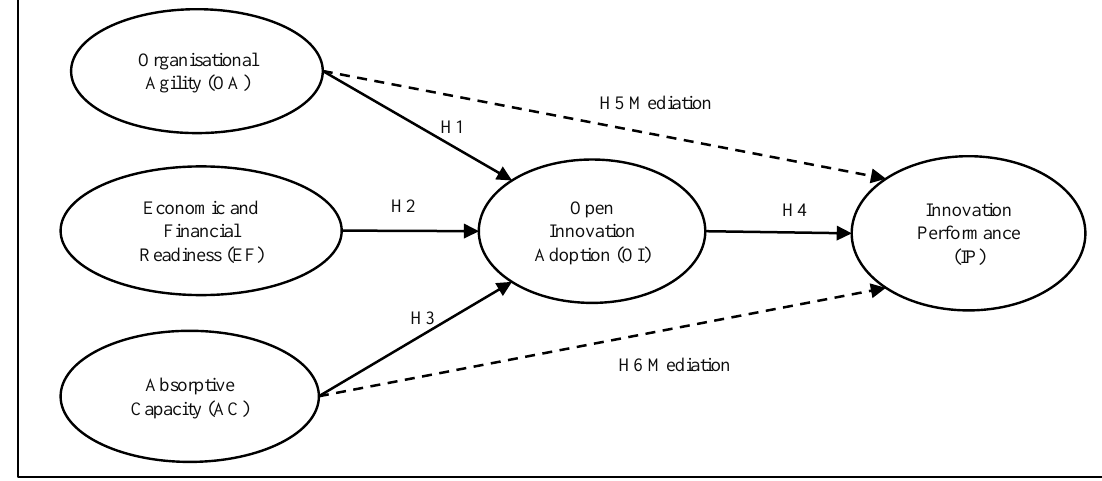
Figure 1. The proposed conceptual framework.